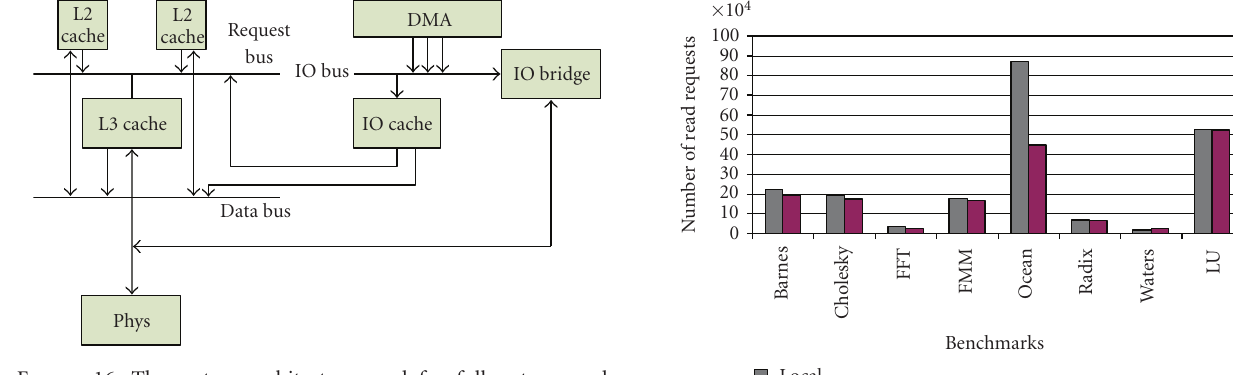
Figure 16: The system architecture used for full-system mode simulation.